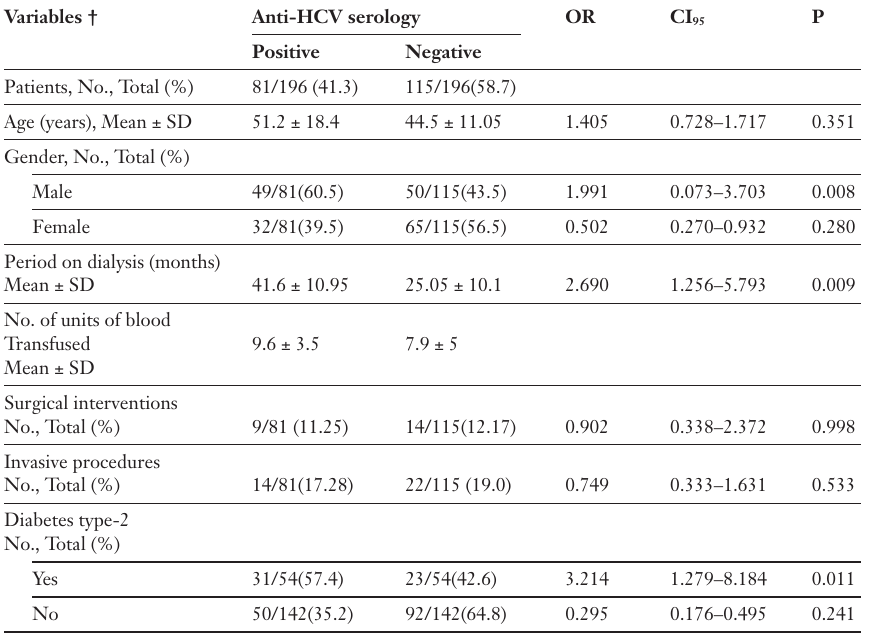
Determinants of HCV seroconversion in the haemodialysis cohort (n = 196) (univariate